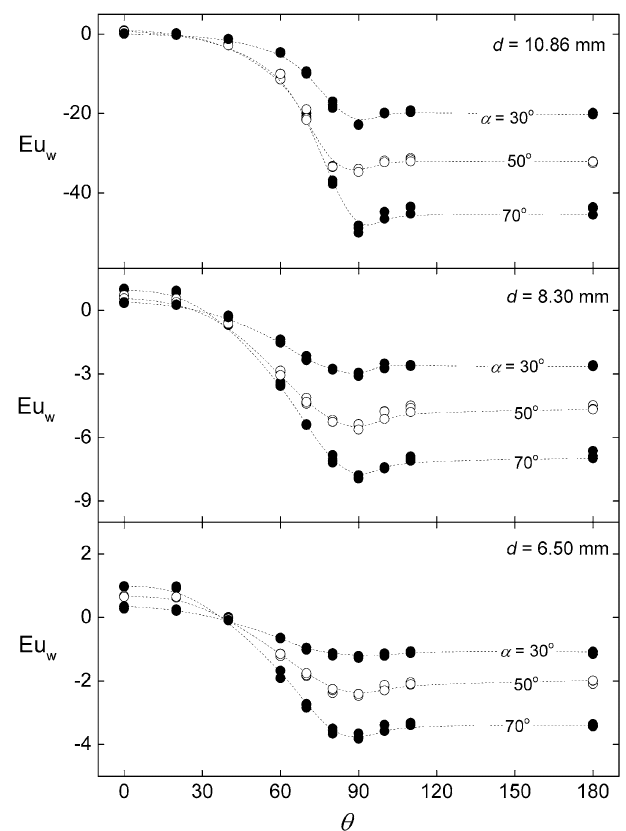
Figure 4. Variation of the wall Euler number around the rod for different inclinations angles and rod diameter. Created with Gnuplot 5.4, www. gnupl ot.